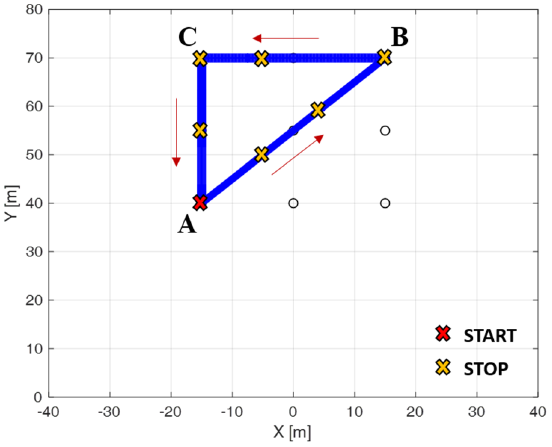
Figure 5. Simulated trajectory.